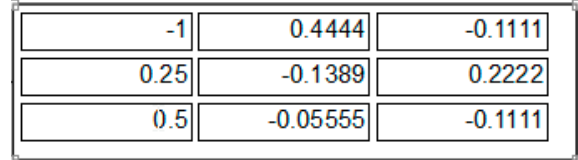
Figure 3. Result of model simulation (just for illustration) for the matrix M indicated in Table 2 (see first row of Table 2), SIMULINK output. Table 2. Components of SIMULINK model to implement Equation (24). Component